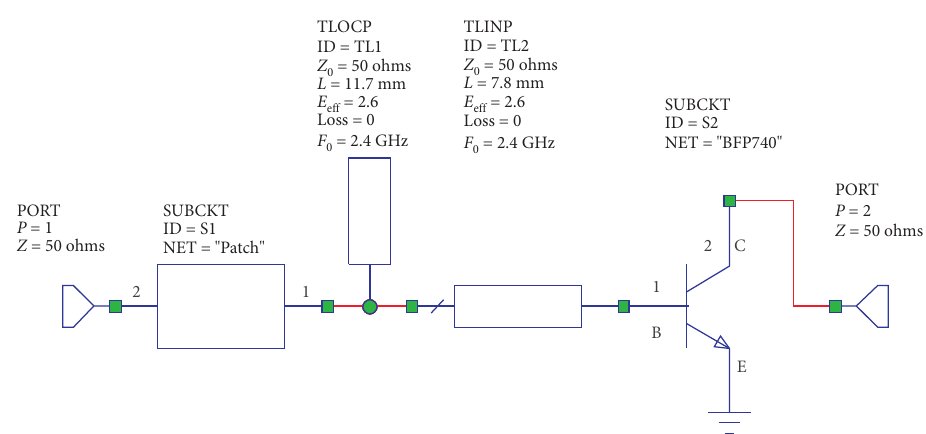
Figure 9: A two-port network model of the active receiving antenna